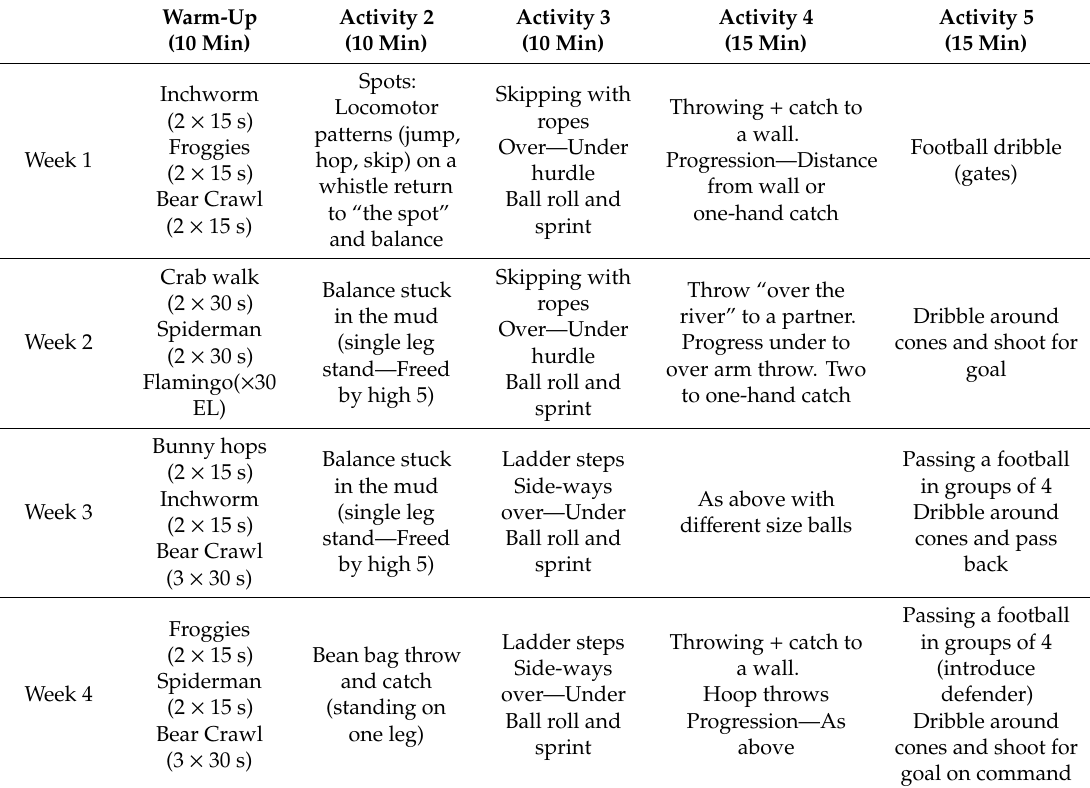
Table 2. Fundamental movement skill training